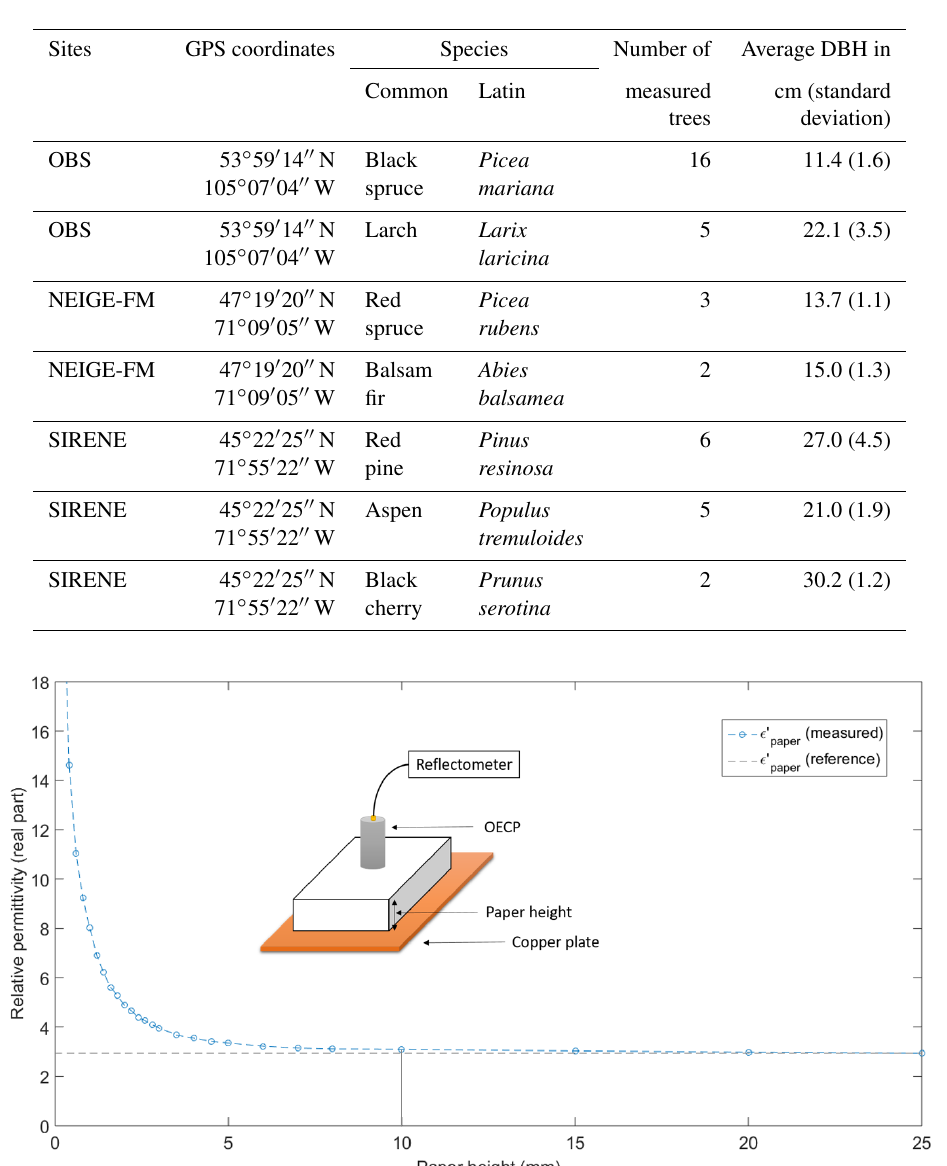
Table 1. Study sites and tree measurement details for Old Black Spruce (OBS), Montmorency Forest research site (NEIGE-FM) and Site Interdisciplinaire de Recherche en Environnement Extérieur (SIRENE). DBH stands for the diameter of the tree at breast height.